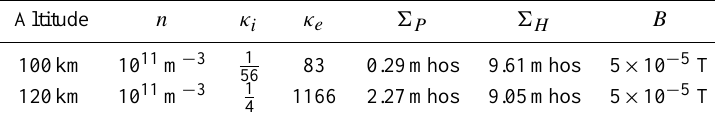
Table 1. Fixed simulation